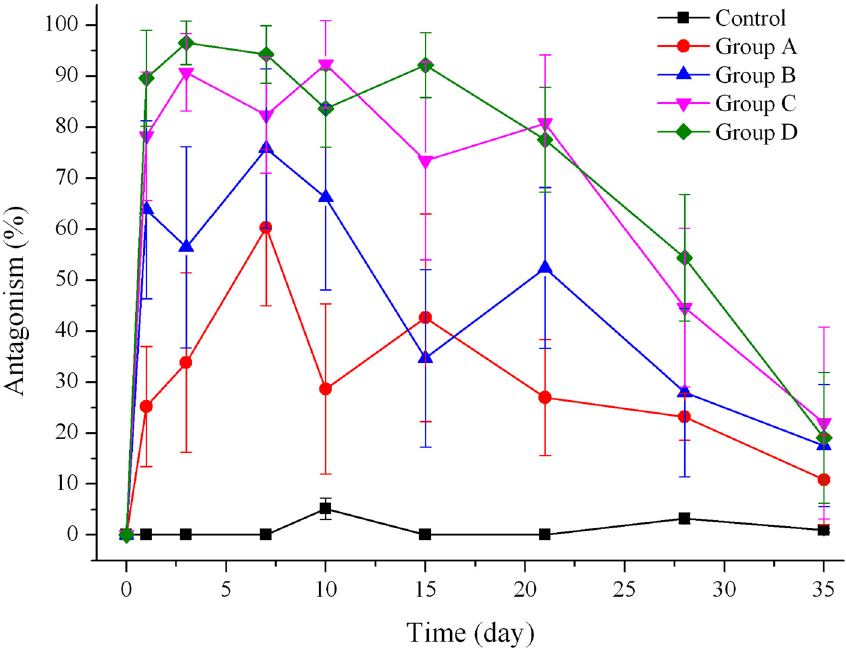
Fig 9. Percent analgesic antagonism-time profile of different doses of nalmefene microspheres (n = 10). Control: blank microspheres; Group A: nalmefene microspheres eq 40 mg nalmefene/kg; Group B: nalmefene microspheres eq 80 mg nalmefene/kg; Group C: nalmefene microspheres eq 160 mg nalmefene/ kg; Group D: nalmefene microspheres eq 320 mg nalmefene/kg.